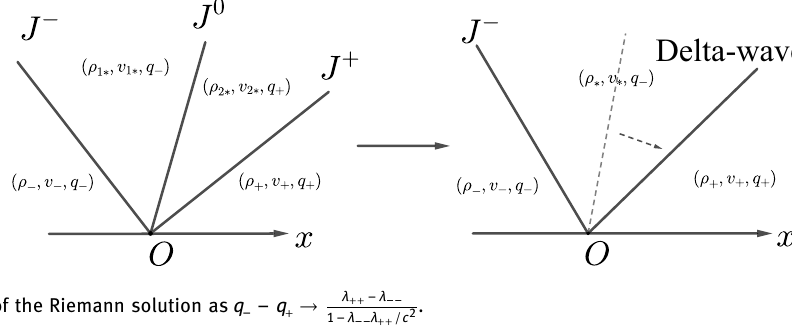
Figure 3: Limit of the Riemann solution